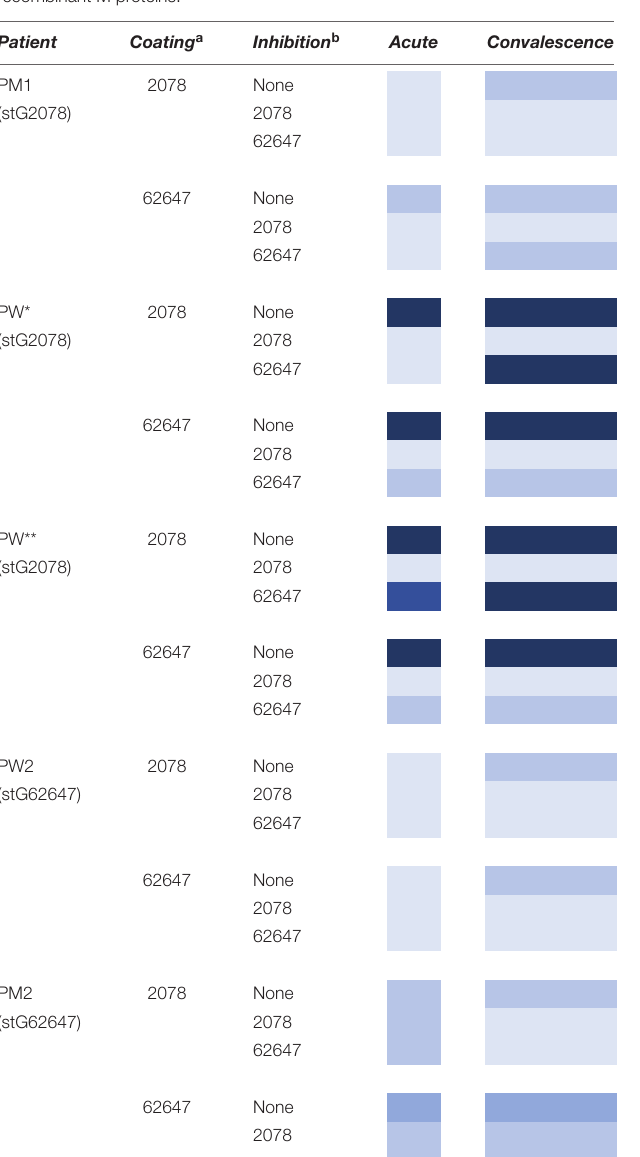
TABLE 2 | Absorbance 415 nm, patient sera and coating with recombinant M proteins.